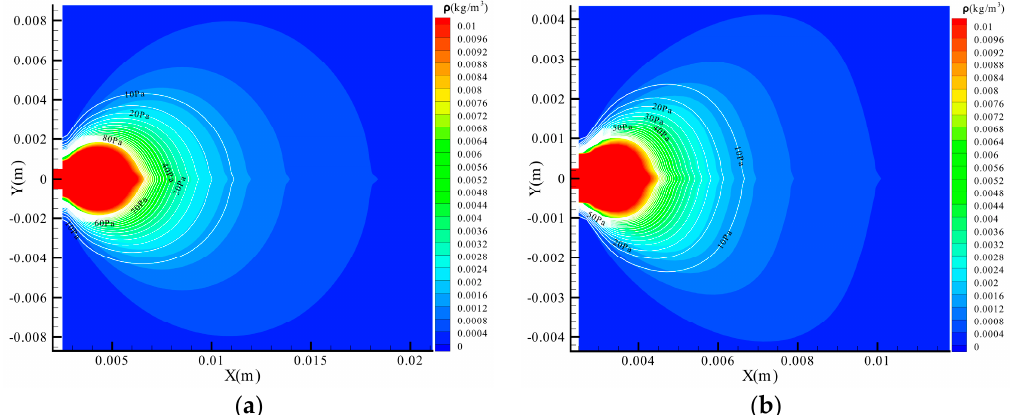
Figure 9. Density contour with pressure contour map of different leak hole diameter. ( a ) 1 mm; ( b ) 0.5 mm.